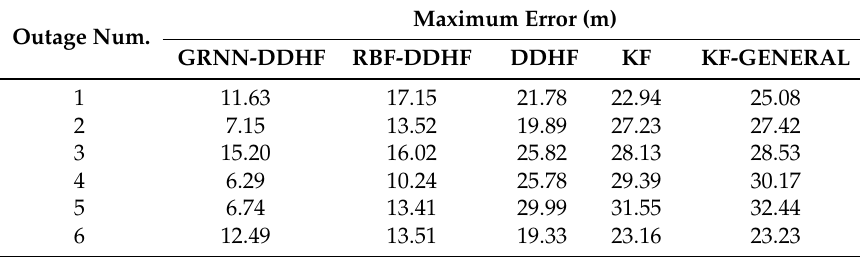
Table 6. Maximum position errors during GPS outages for Trajectory 2.